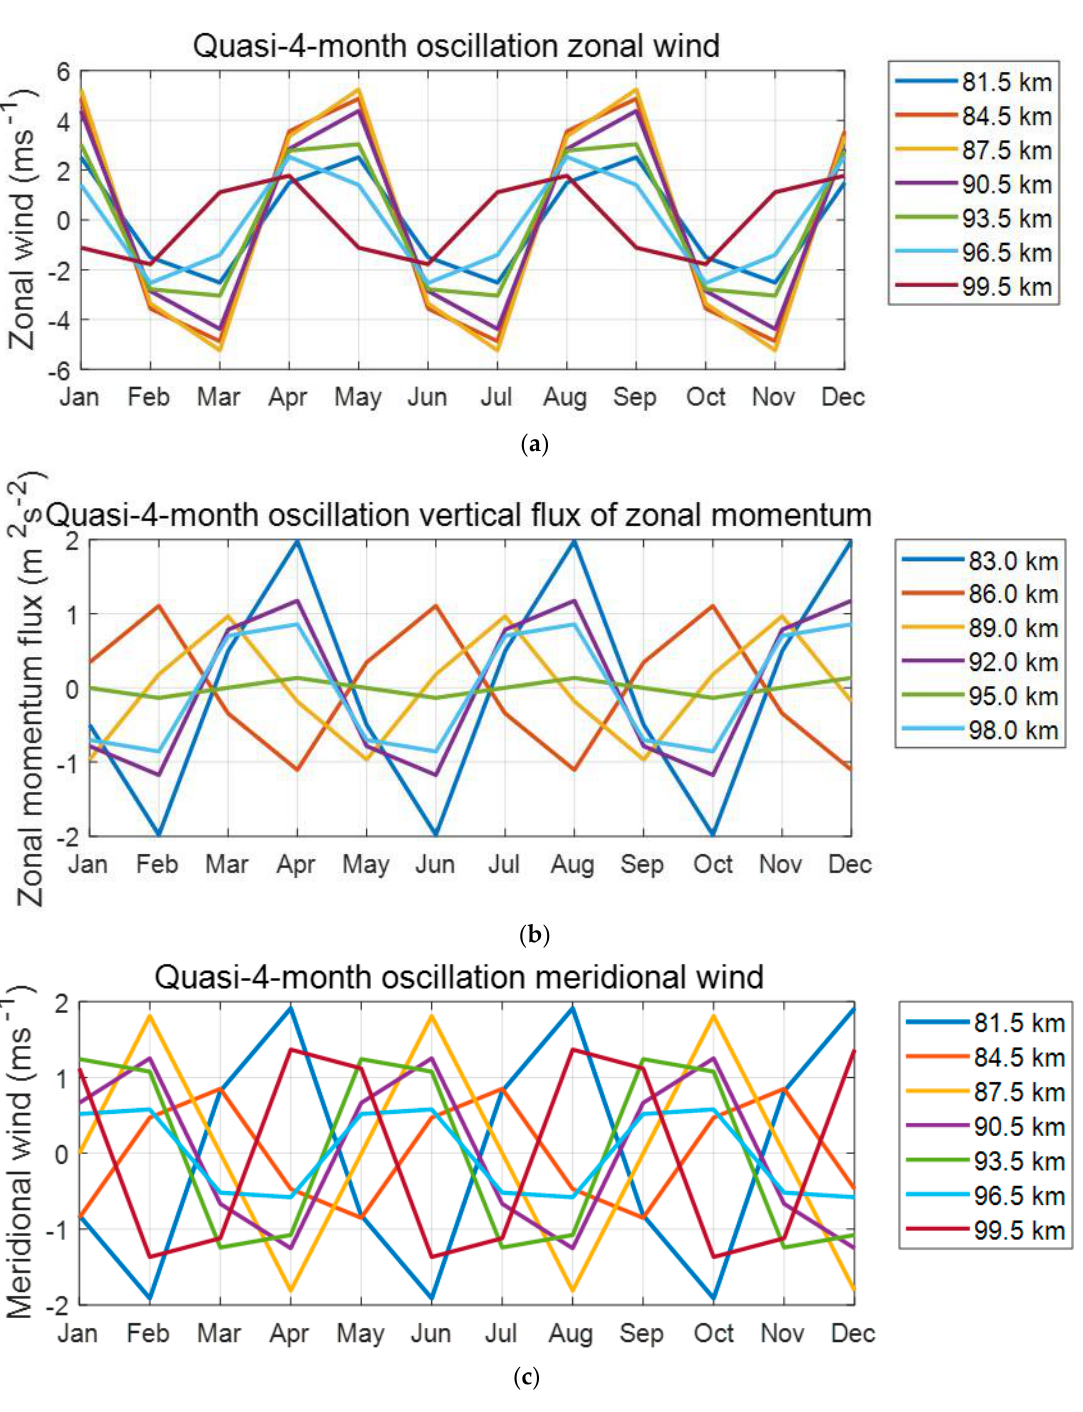
Figure 7. Quasi-4-month oscillation components for zonal winds ( top ), zonal momentum flux ( middle ), and meridional wind ( bottom ) at varying altitudes. ( a ) Quasi-4-month oscillation zonal wind ( b ) Quasi-4-month oscillation vertical flux of zonal momentum ( c ) Quasi-4-month oscillation meridional wind